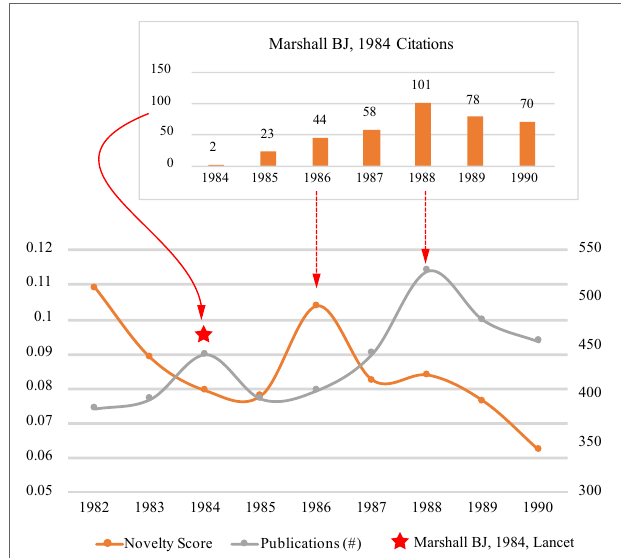
FIGURE 5 | Co-evolution of the novelty and growth of research on Peptic Ulcer